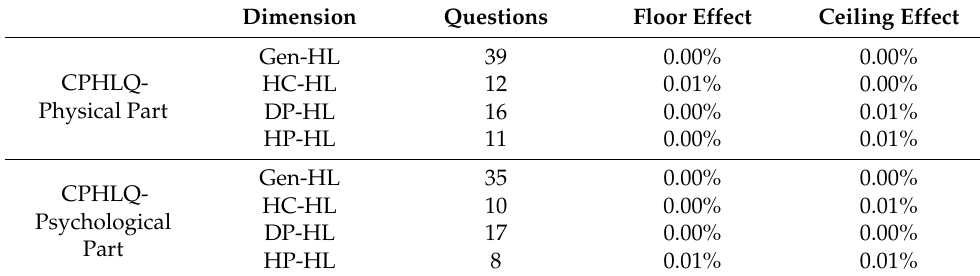
Table 6. Floor and ceiling effect of CPHLQ.